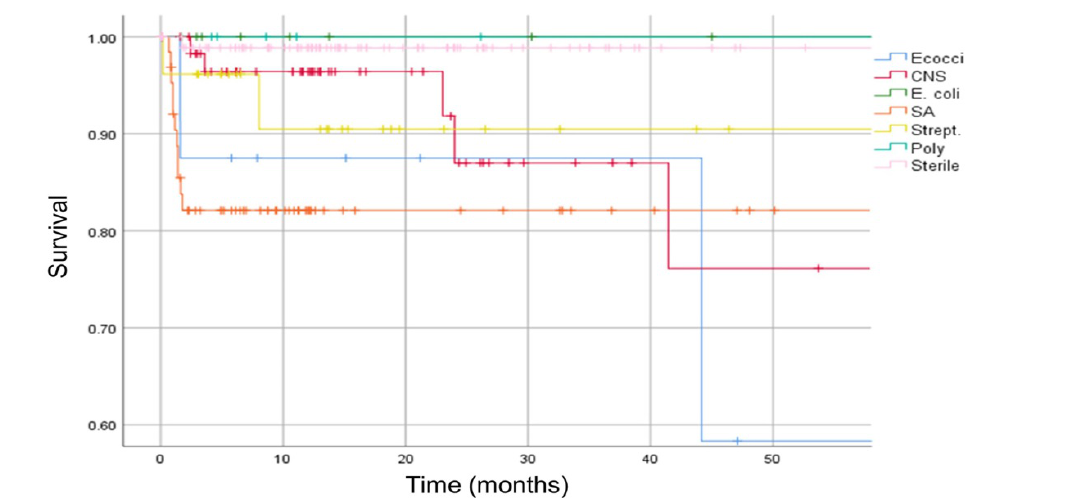
Figure 6. Kaplan-Meier survival curve. The analysis is separated in different infecting organisms. Vertical marks indicate censoring. Ecocci = enterococci, CNS = coagulase-negative staphylococci, E. coli = Escherichia coli , SA = Staphylococcus aureus , Strept. = Streptococcus spp. , Poly = polymicrobial